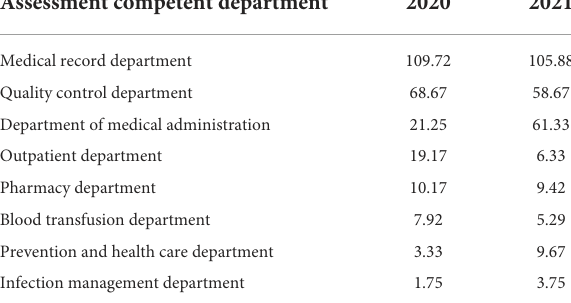
TABLE 8 The monthly average scores of assessment competent department in 2020 and 2021 (scores).